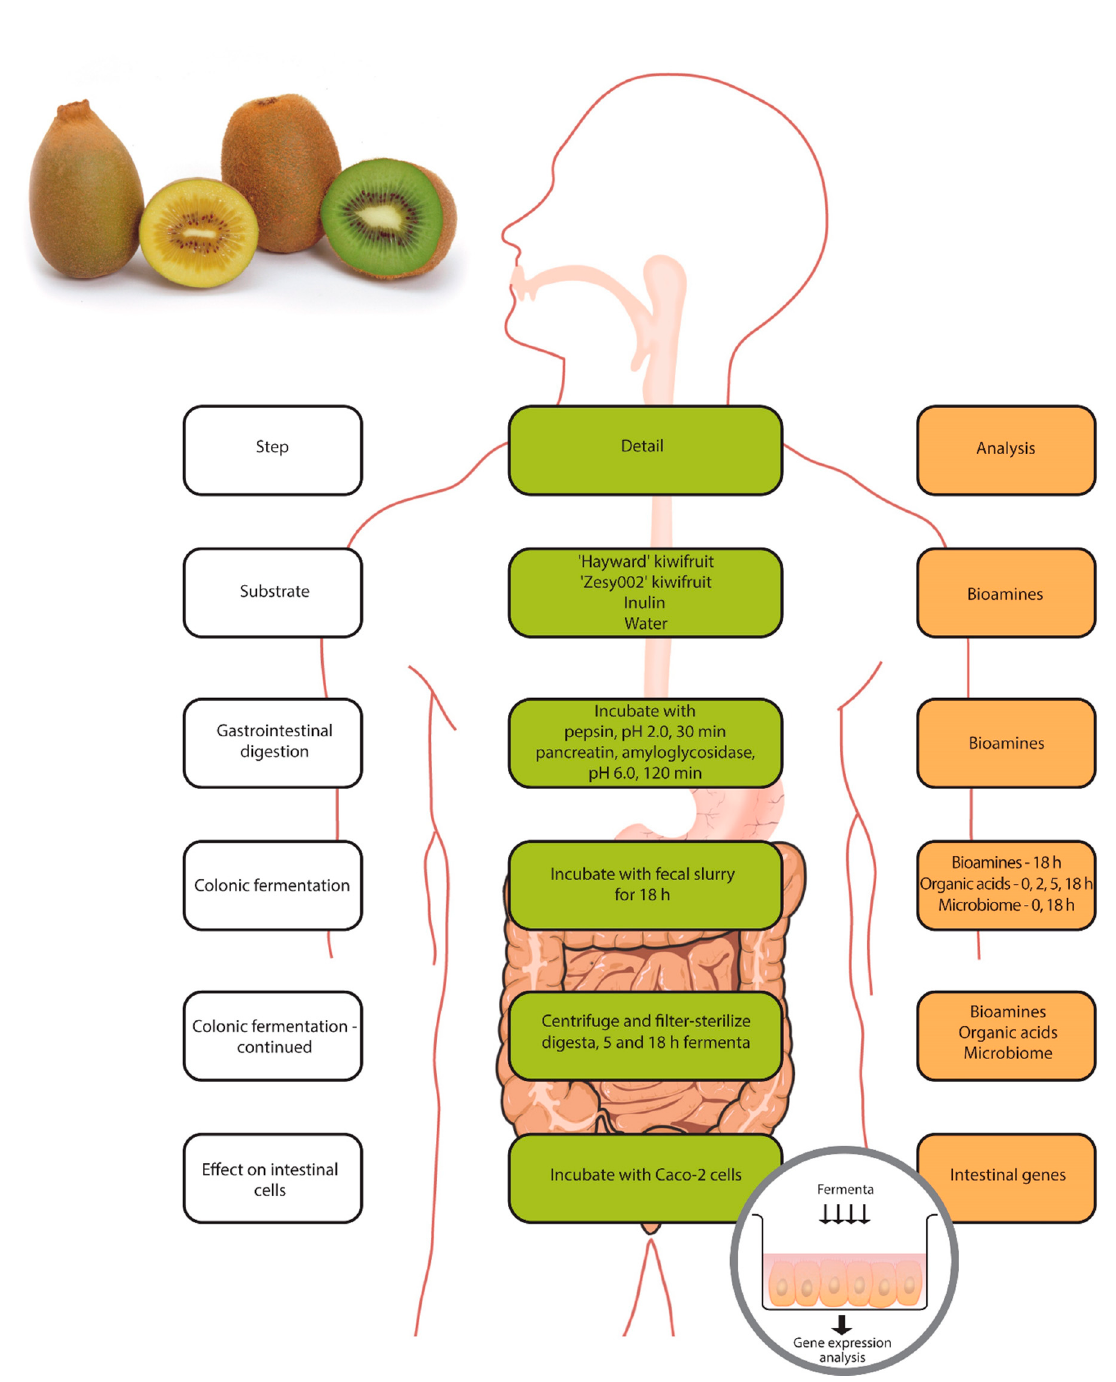
Figure 1. An outline of the experimental protocol used in this study.